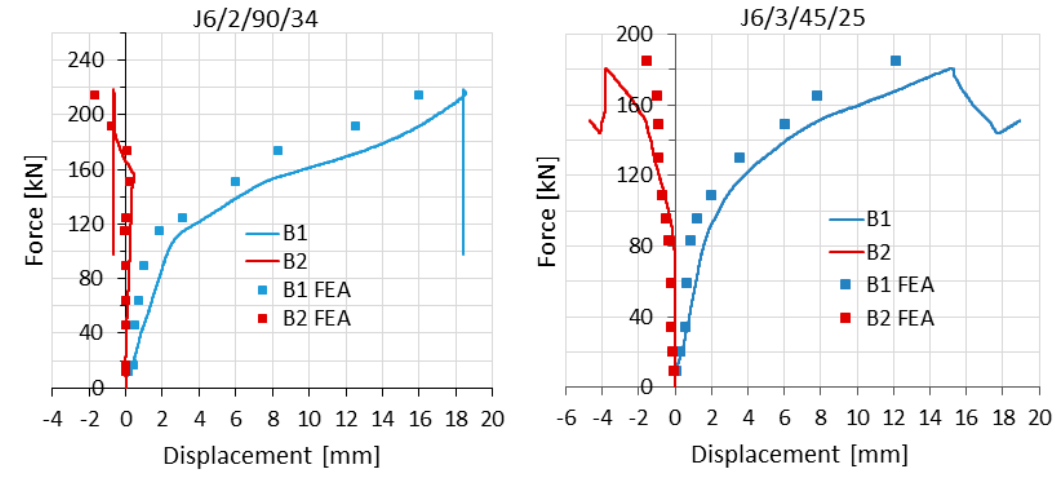
Figure 10. Load–horizontal displacement curves gained from experimental tests and numerical simulations for example elements.